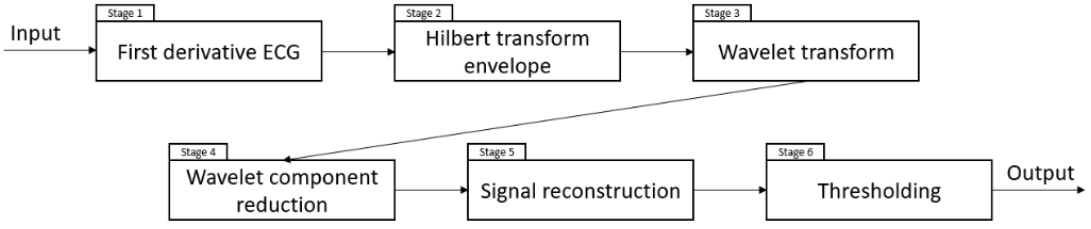
Figure 1. Block diagram of the implemented method.